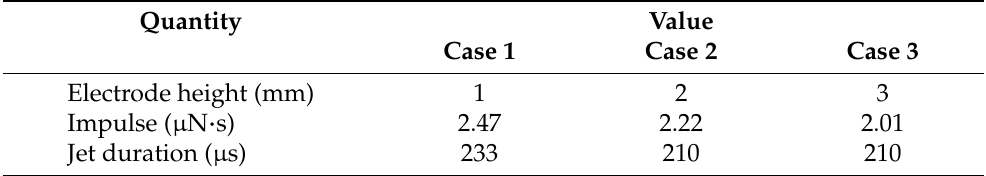
Table 5. Effect of Electrode Location.